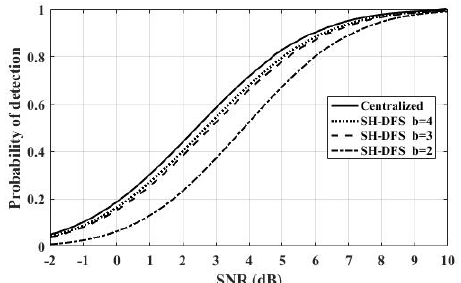
Figure 11. The probability of detection of the clustered distributed system with SH-DFS ( b = 2, 3, 4) and the centralized system versus SNR.